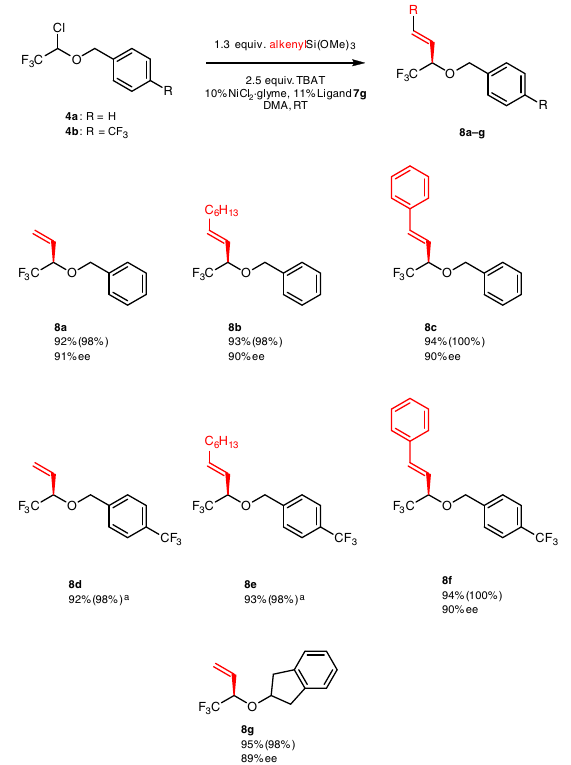
Fig. 4 Selected examples of the cross-coupling reaction with alkenyl silanes. Isolated yield is reported ( 19 F NMR yield is given in brackets). Reaction